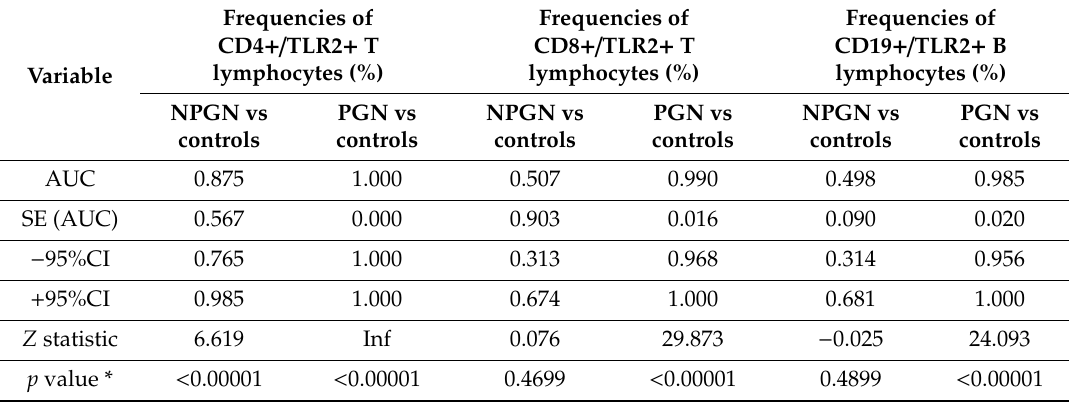
Table 6. ROC curve analysis to determine the diagnostic accuracy of TLR2 expression on T and B lymphocyte subsets to discriminate between patients and